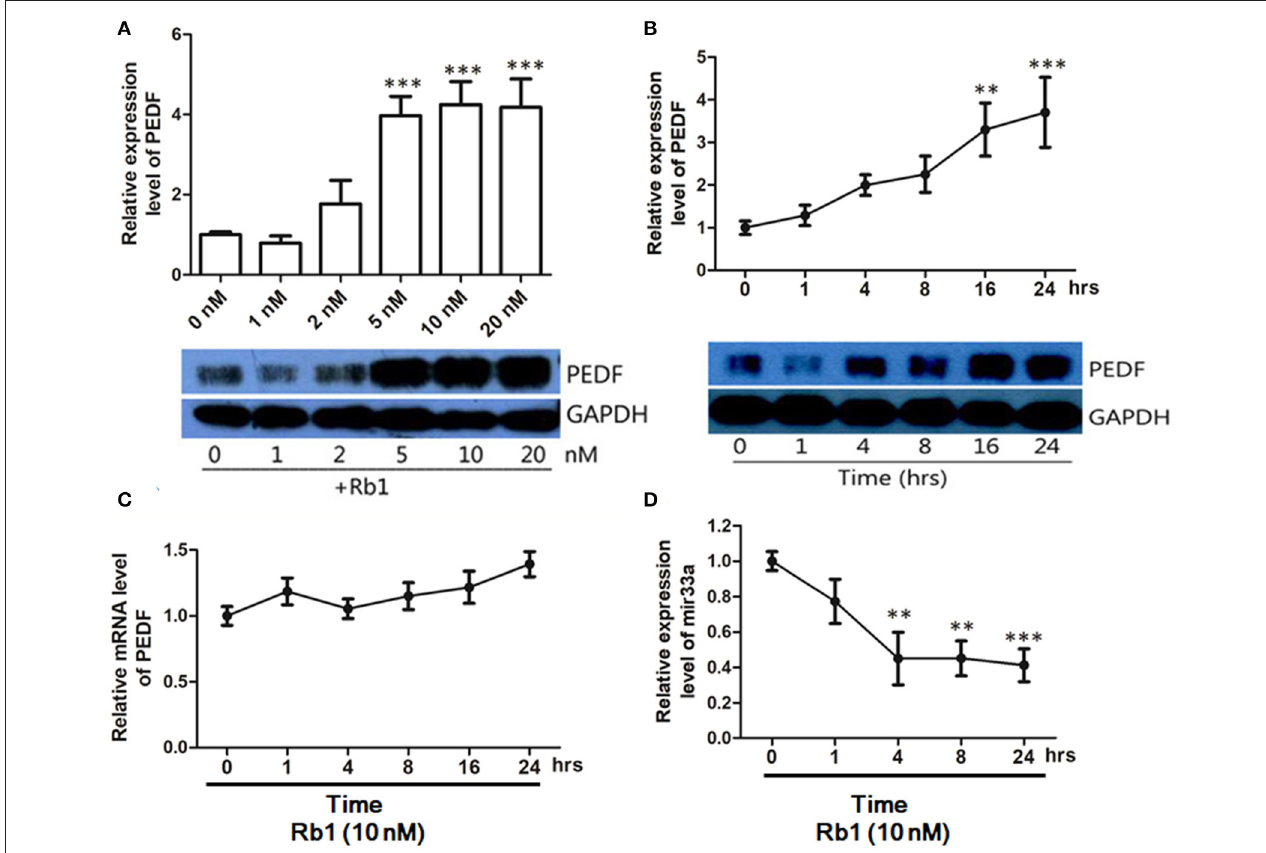
FIGURE 1 | PEDF protein and mRNA expression in HUVECs treated with Ginsenoside Rb1. (A) Western blot analysis and quantification of PEDF expression in HUVECs treated with different concentrations of Rb1. Culture medium with DMSO (1%) served as the control group. (B) Western blot analysis and quantification of PEDF expression in HUVECs treated with 10nM Rb1 at different timepoints. (C) PEDF mRNA expression in HUVECs treated with 10nM of Rb1 at different timepoints. (D) MicroRNA-33a expression levels in HUVECs treated with 10nM Rb1 at different timepoints. The relative expression of miR-33a was calculated against U6 RNA using the comparative Ct method (2 − 11 Ct ). Each value was expressed as fold of control mean + S.EM. ( n = 3). **vs. con p < 0.01; ***vs. con p <